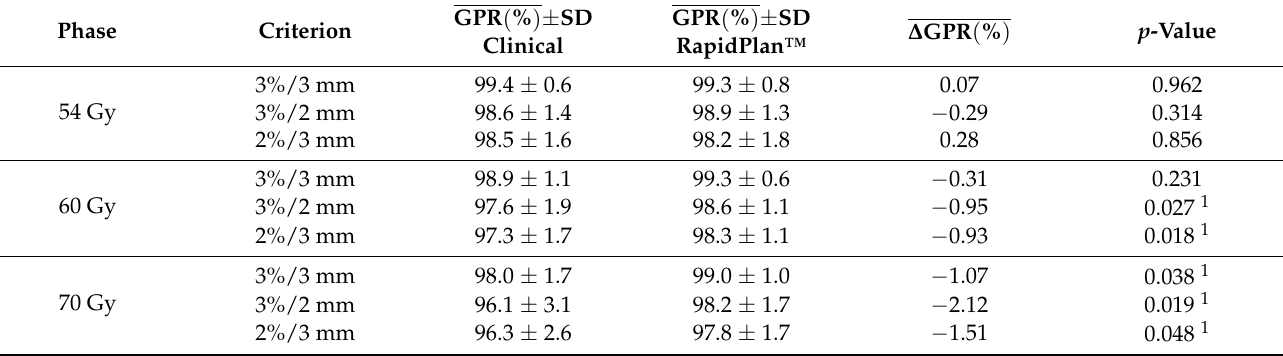
Table 4. Mean 2D gamma passing rates (GPR ( % ) ) of the clinical and RapidPlan™ plans in the open-loop validation set.